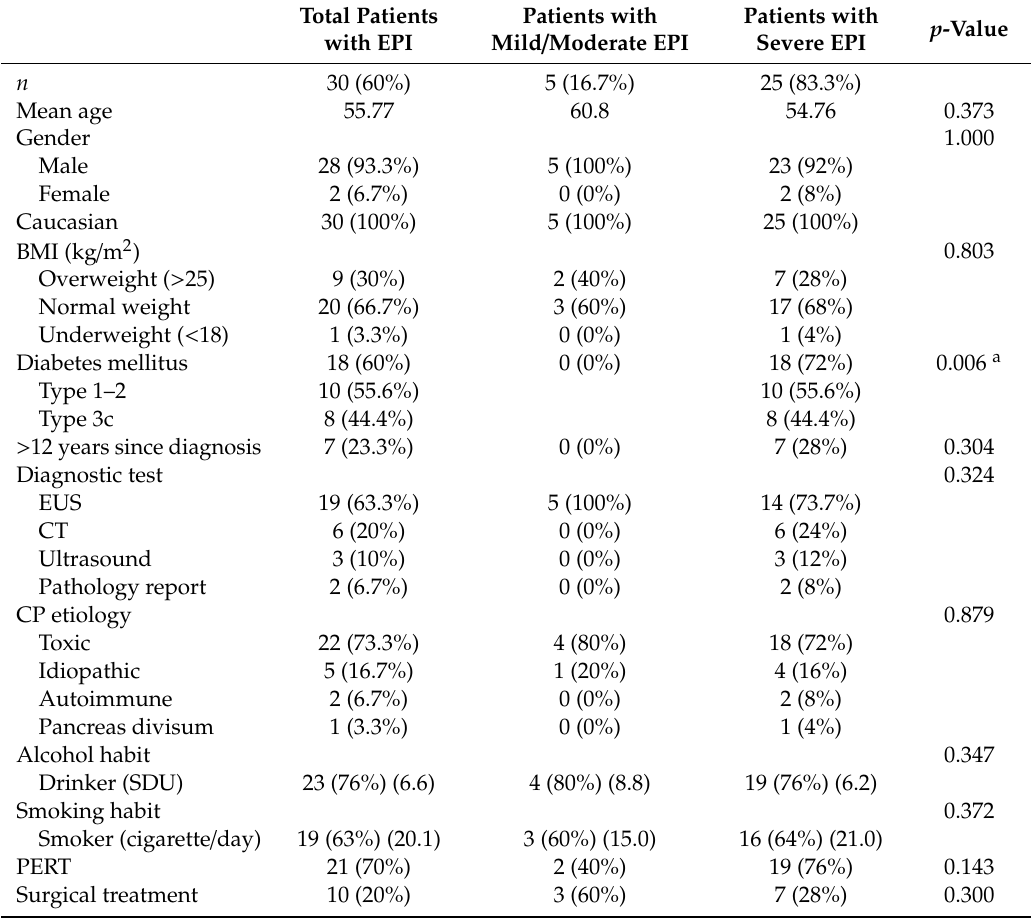
Table 7. Patient characteristics of patients with mild / moderate versus severe EPI ( n =